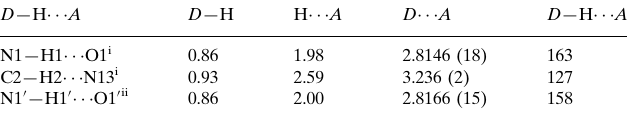
Hydrogen-bond geometry (A˚ , (cid:1)